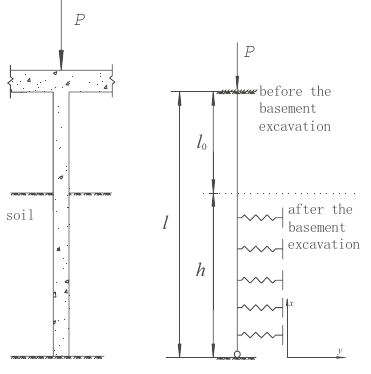
Figure 4. Buckling analysis